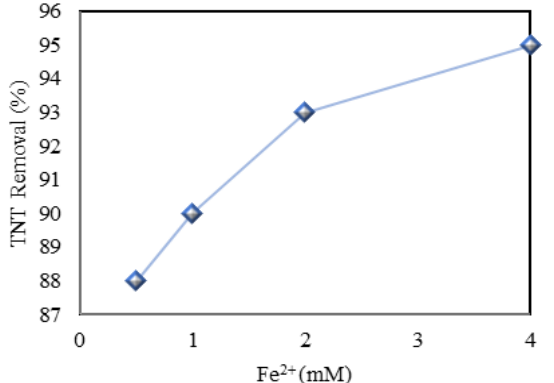
Fig. 4. Effect of Fe 2+ concentration in Fenton process on TNT removal